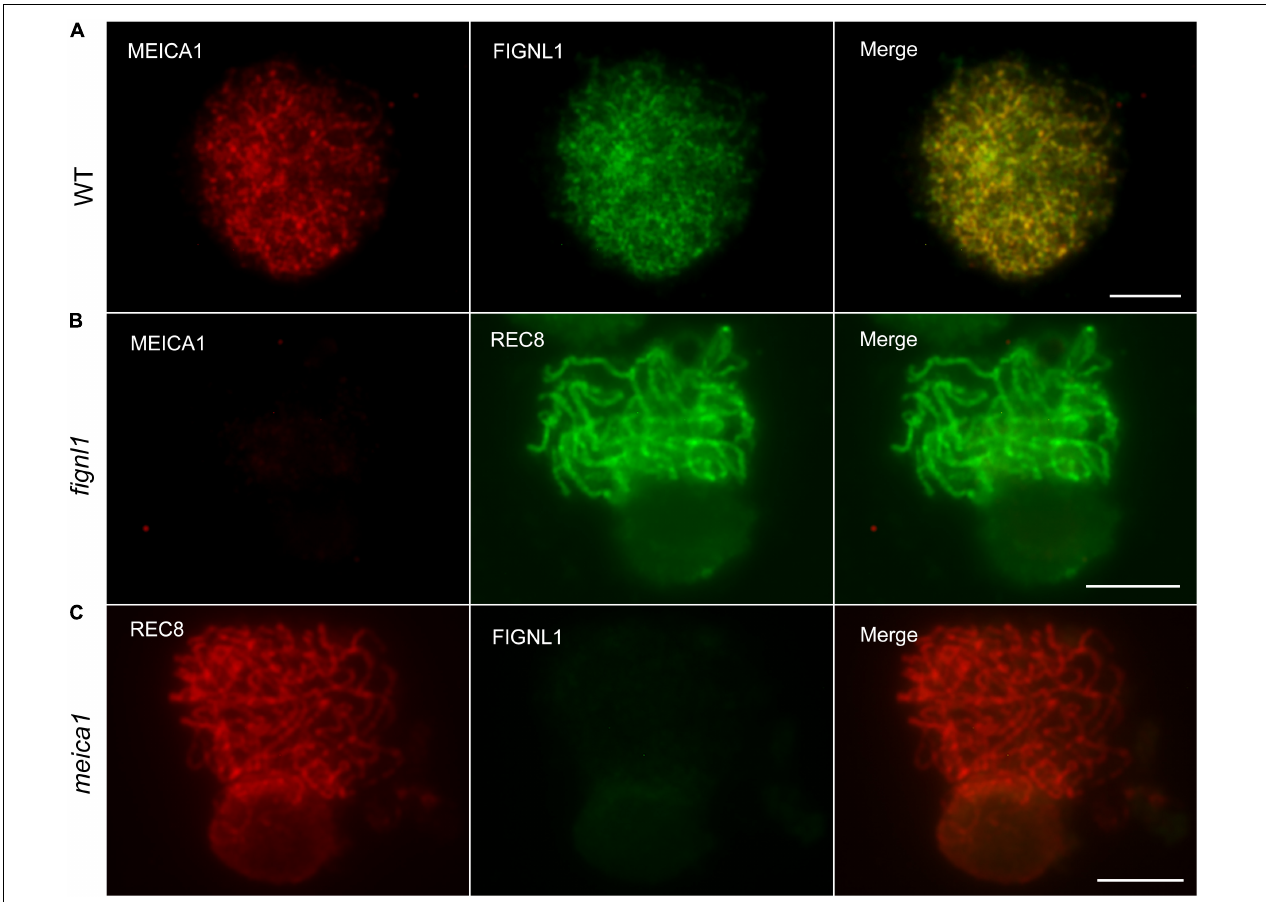
FIGURE 7 | FIGNL1 colocalizes with MEICA1 and is required for the loading of MEICA1 (and vice versa ). (A) FIGNL1 almost completely colocalizes with MEICA1 foci. (B) The immunodetection of MEICA1 in fignl1 . (C) The immunodetection of FIGNL1 in meica1 . Bars, 5 µ